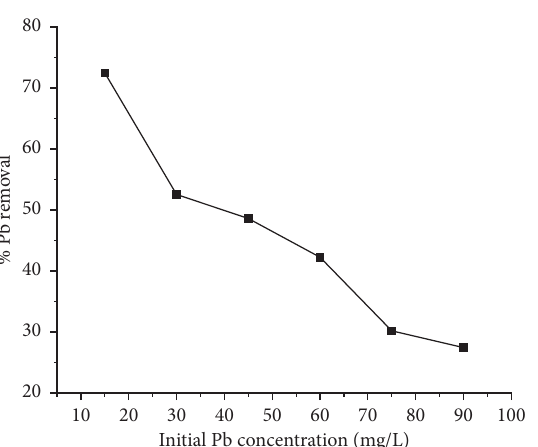
Figure 4: Efects of initial Pb concentration on lead removal.